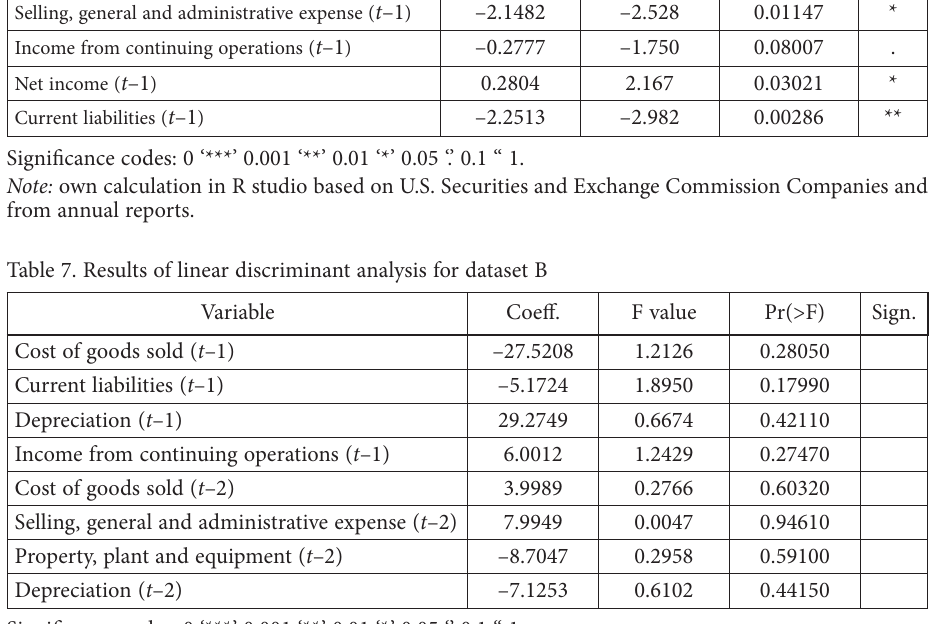
Table 6. Results of logistic regression for dataset B Variable Coeff. Z value Sign.